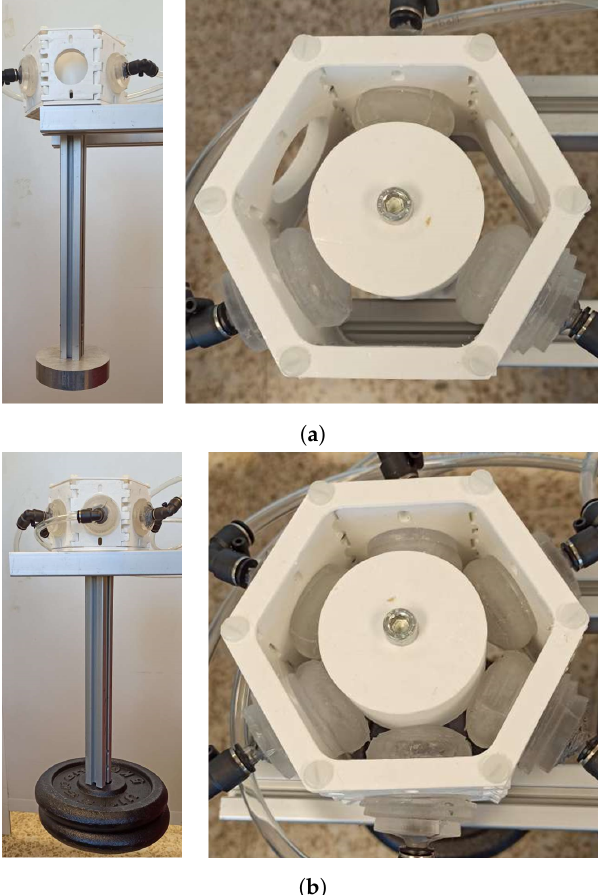
Figure 14. Slip test setup in a hexagonal configuration: ( a ) Soft gripper with three soft actuators; ( b ) Soft gripper with six soft